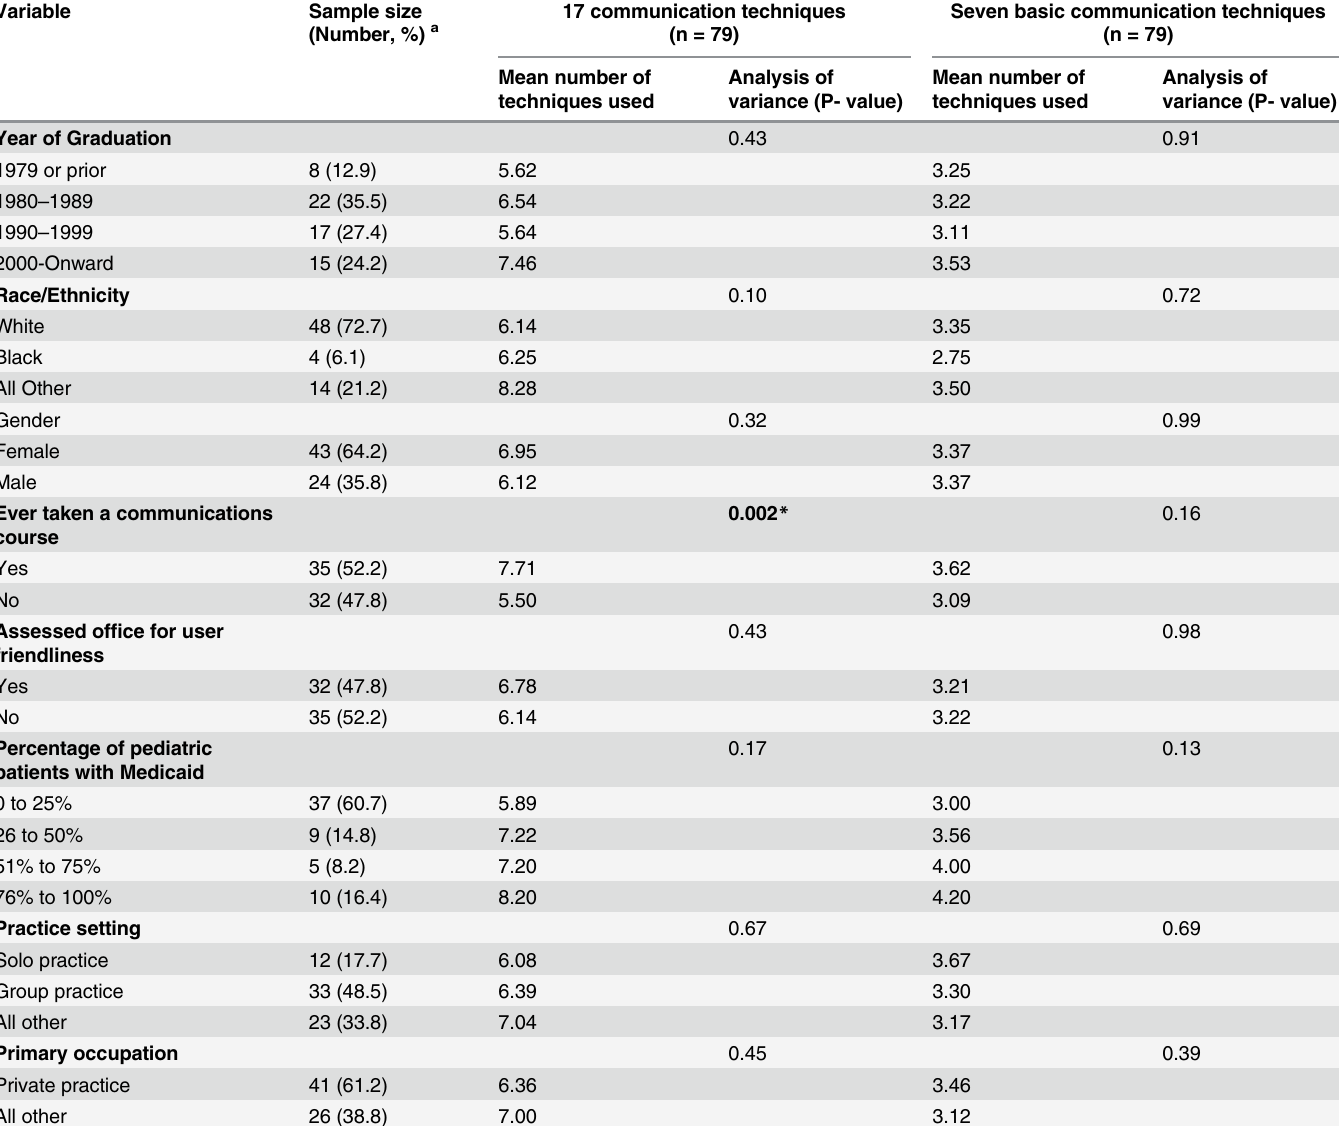
Table 5. Bivariate analysis of predictor variables and mean communication techniques used routinely by family